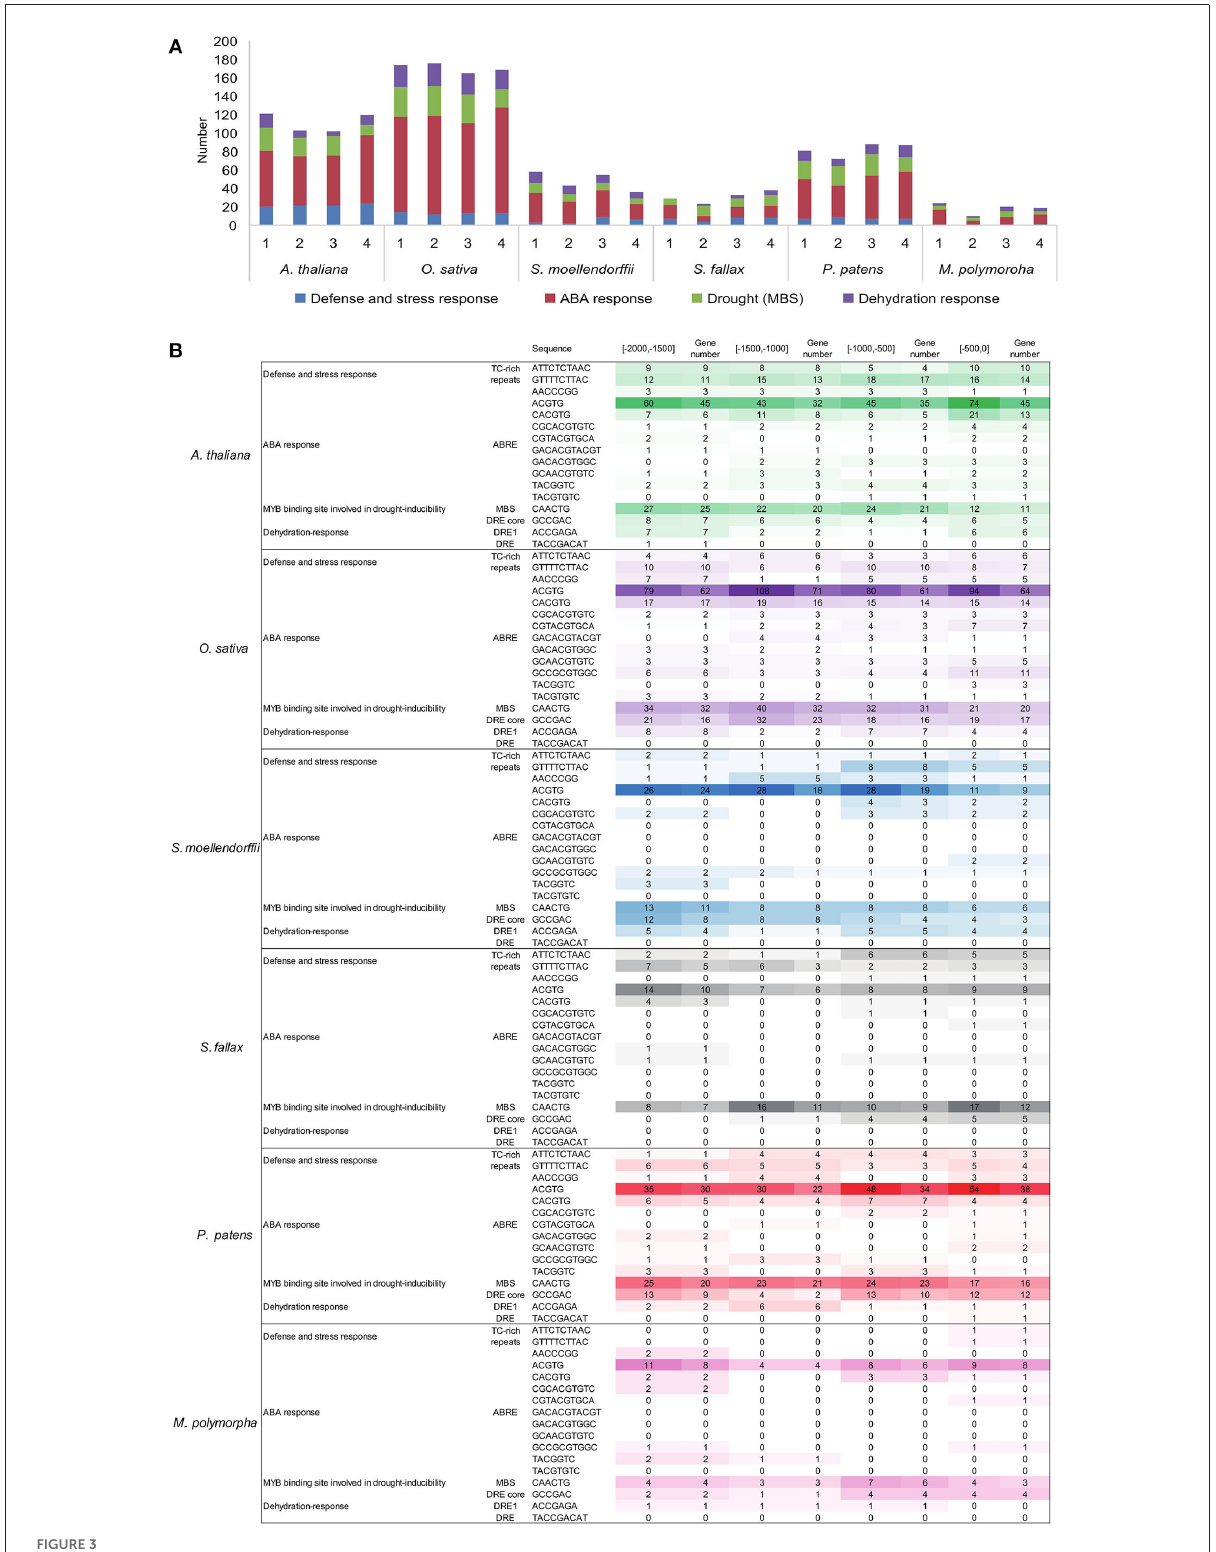
FIGURE3 Promoter analyses of C2H2-ZFPs in the representatives of land plant lineages. Drought, dehydration, defense, and ABA-related cis-acting elements were counted for 2000 bp upstream from ATG. (A) The number of the drought, dehydration, defense, and ABA-related cis-acting elements in the C2H2-ZFP promoter region of each representative. (B) The details of the of drought, dehydration, defense, and ABA-related cis-acting elements in the C2H2-ZFP promoter region of each